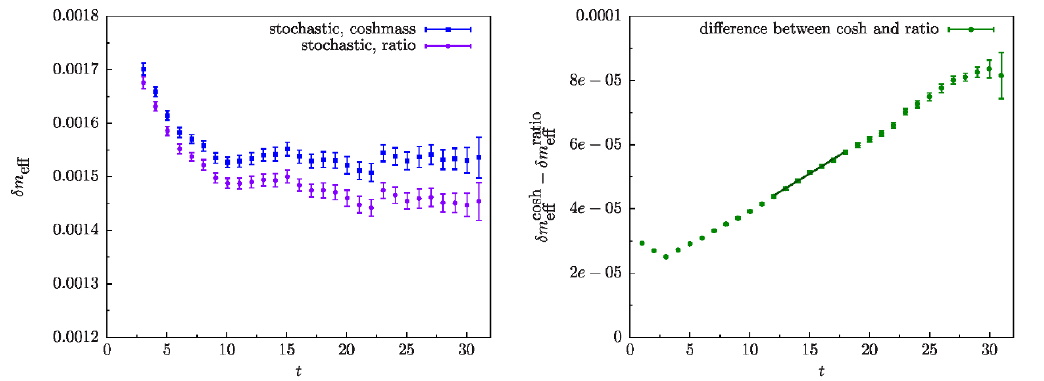
Figure 5 . The QED correction to the e(cid:11)ective mass of a charged kaon from the stochastic data. The plot on the left shows the results using the cosh-mass method (blue squares) and the ratio method (purple circles). The plot on the right shows the correlated di(cid:11)erence between the results from cosh-mass and ratio